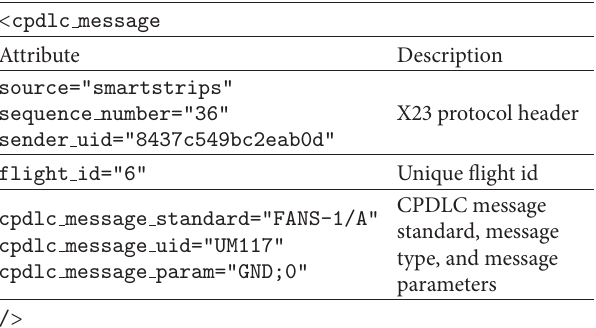
Table 4: The flight BER561K is contacted by the GND controller.